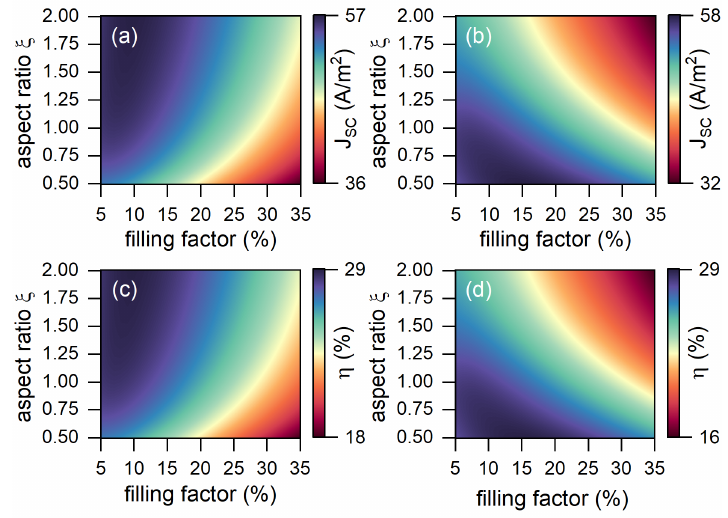
Figure 6. ( a , b ) The surface current density and ( c , d ) the efficiency of the TPP-based solar cell in the case when the electric field vector is perpendicular ( a , c ) and parallel ( b , d ) to the y axis.